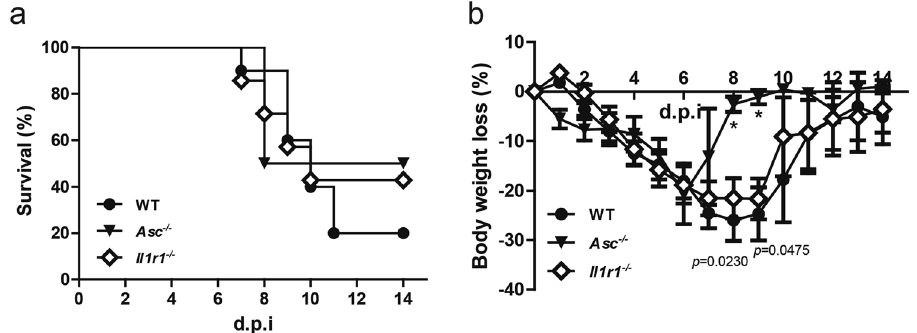
Figure 6. Deficiency of ASC or IL-1 receptor reduces the mortality and weight loss after H7N9 infection. ( a ) WT (n = 18), Asc − / − (n = 16) and Il1r1 − / − (n = 14) mice were infected as in Fig. 2, and survival was monitored daily for 14 days. ( b ) The percentage of weight loss from mice shown in ( a ). The weight loss between WT and Asc − / − mice showed statistic significance (P < 0.05) at 8 and 9 d.p.i. Data are pooled from three independent infection experiments. * P <